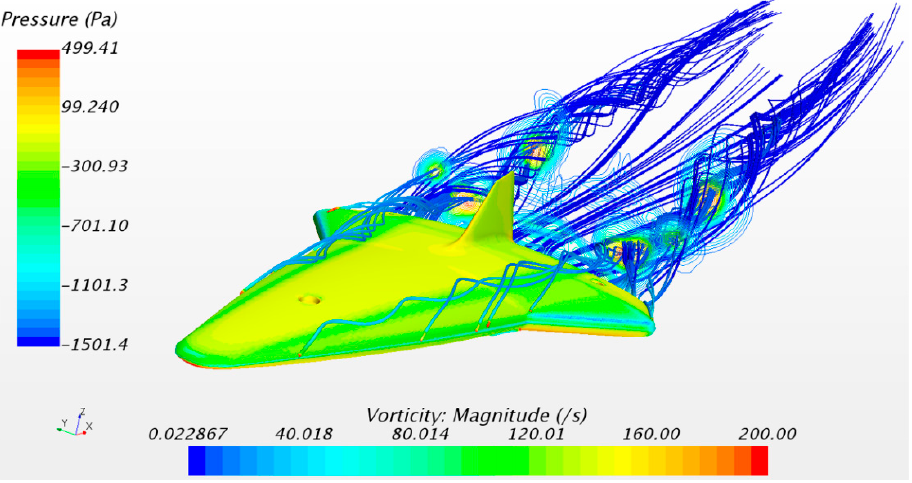
Figure 4. Vertical static drift test for varying pitch angle.